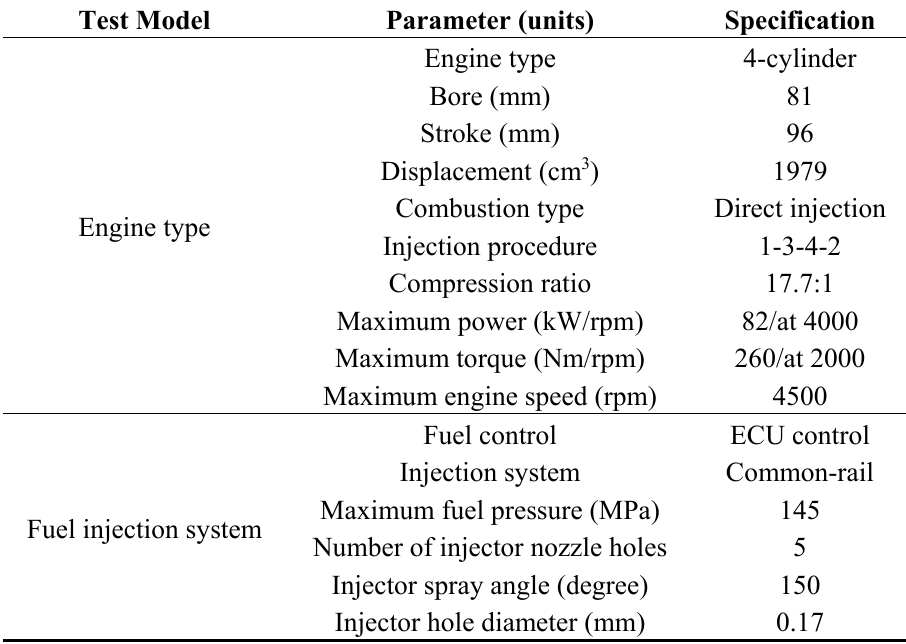
Table 3. Specifications of the test engine.